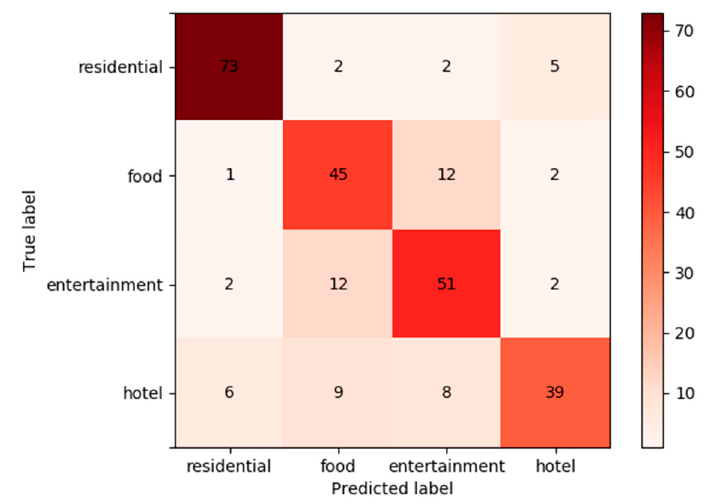
Figure 12. The confusion matrix of prediction.